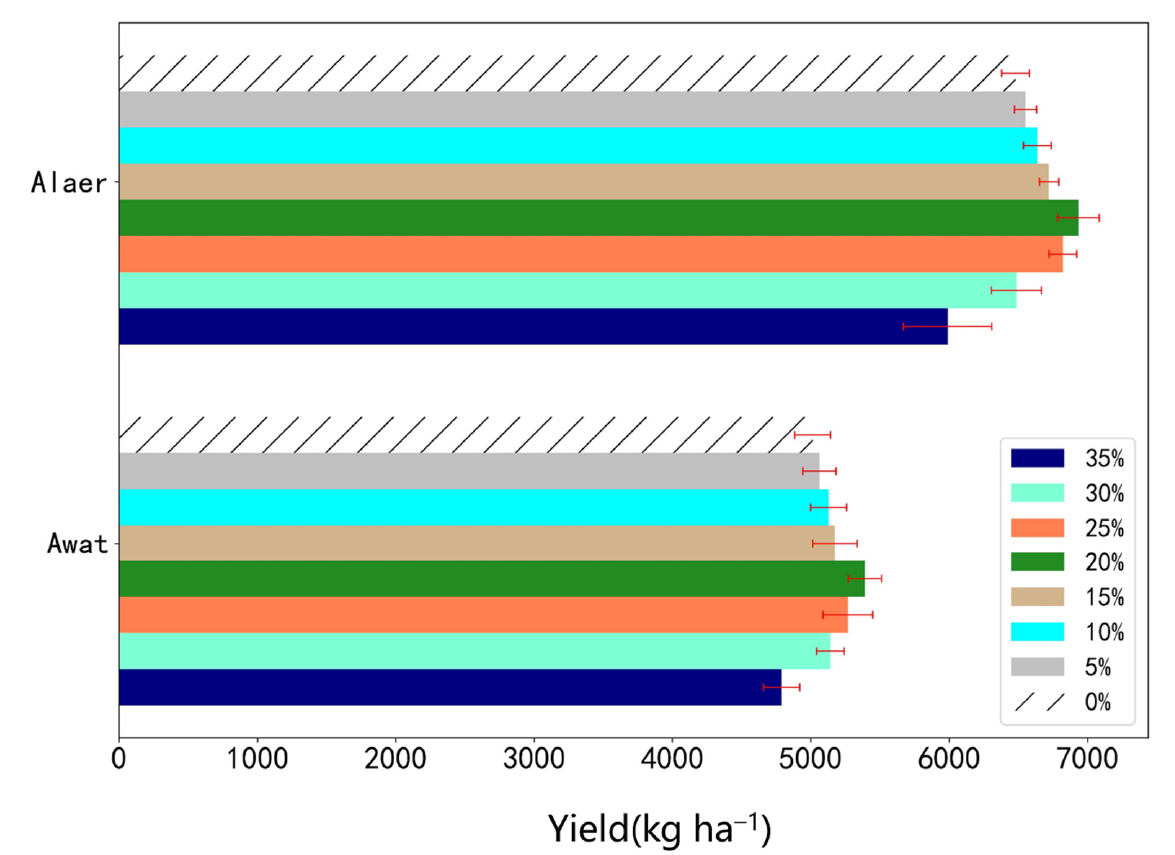
Figure 9. Measured final pear yield for all treatments in Alaer and Awat. The improved model was used to simulate the yield under different pruning intensi- ties. We set the pruning intensities to unpruned, 5%, 10%, 15%, 20%, 25%, 30%, 35%. The simulated results showed that the effect of pruning intensity on yield first increased and then decreased (Figure 10), and 20% pruning showed the highest yield, which was consis- tent with the actual observed results (Figure 9). The reason for this may be that the pruning intensity was low, and so a large number of vegetative branches were retained, resulting in less and uneven light exposure in the middle and lower canopy. As the pruning intensity increased, the canopy light condition and the fruit quality were improved. However, when pruning intensity exceeded a certain limit, there was a large reduction in the branches and leaves in the canopy, leading to insufficient dry matter production and lower